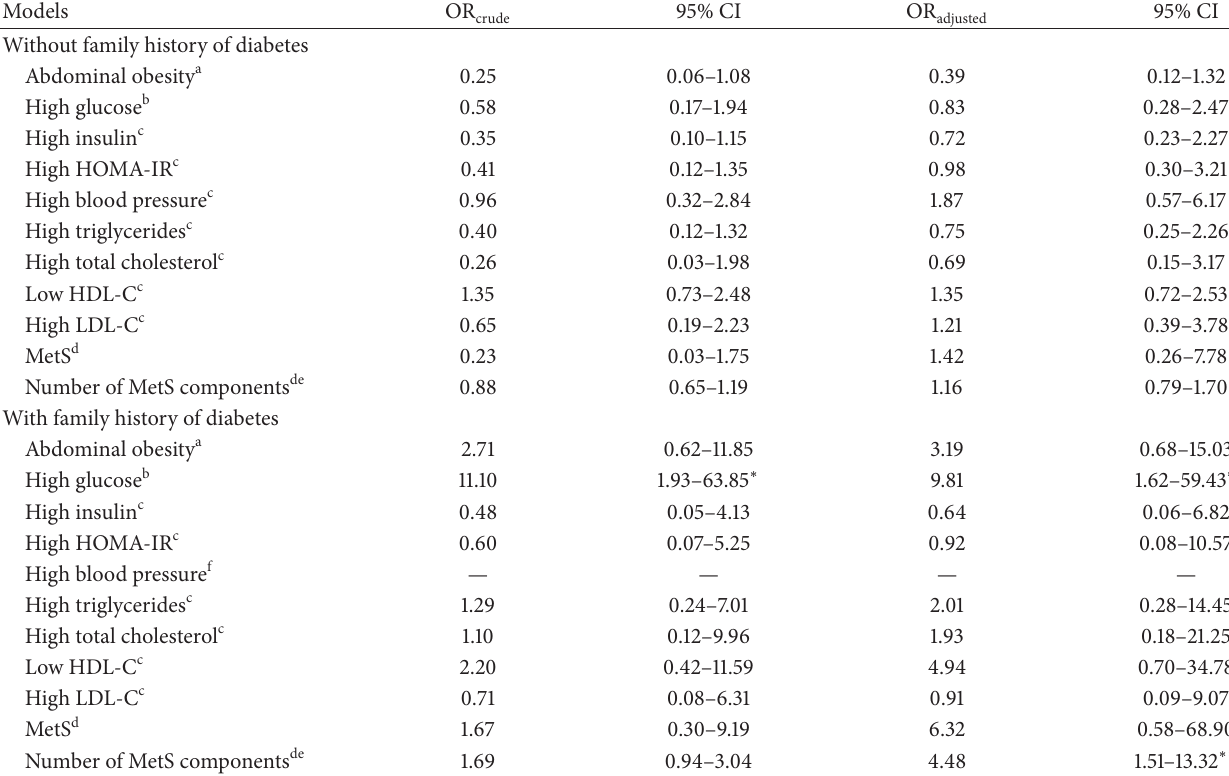
Table 5: Associations between elevated urine albumin concentration and metabolic syndrome or metabolic markers, stratified according to family history of